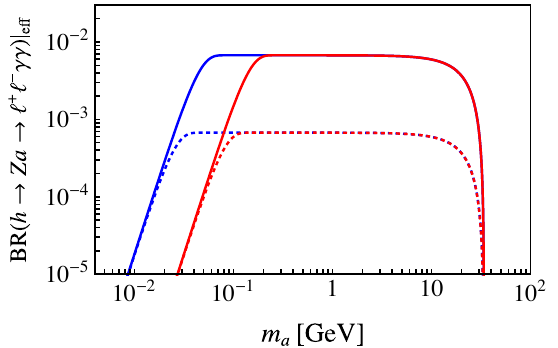
(cid:13)(cid:13) branching ratio !